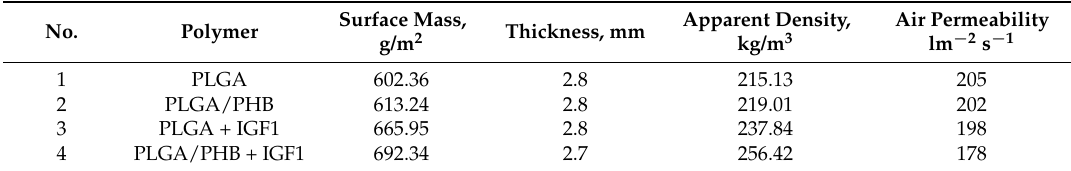
Table 4. Implantable material characteristics.